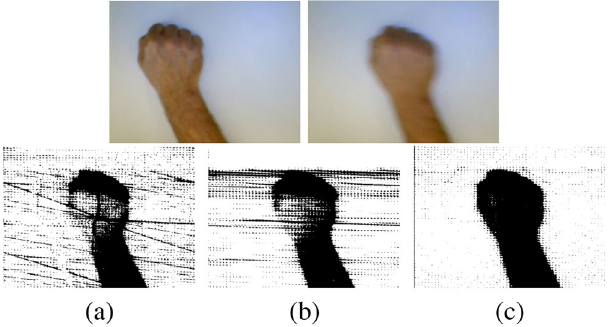
Figure 5. Comparison of optical flow diagrams. ( a ) traditional HS model, ( b ) traditional LK model, ( c ) our